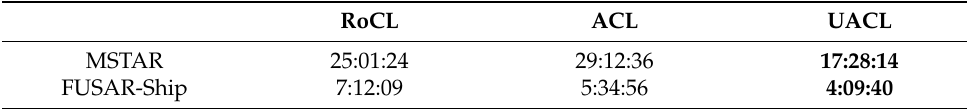
Table 16. The training times of adversarial contrastive pretraining defenses. RoCL ACL UACL MSTAR